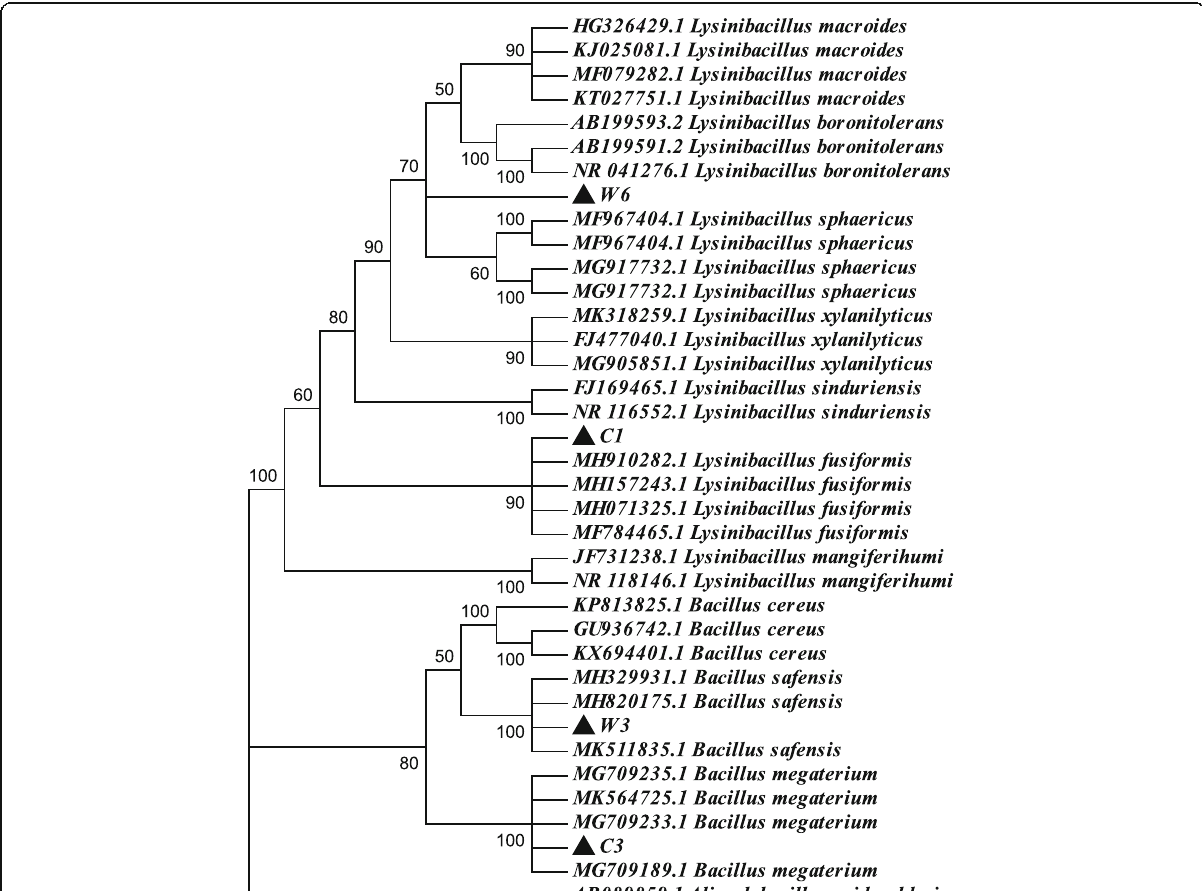
Fig. 3 Phylogenic relationships of Bacillus spp. ( B. megaterium C3 and B. safensis VW3) and Lysinibacillus spp. ( L. fusiformis C1 and Lysinibacillus sp. VW6) based on 16S rDNA sequences (maximum likelihood method). Numbers on the branches indicate bootstrap values. Alicyclobacillus acidocaldarius was used as a